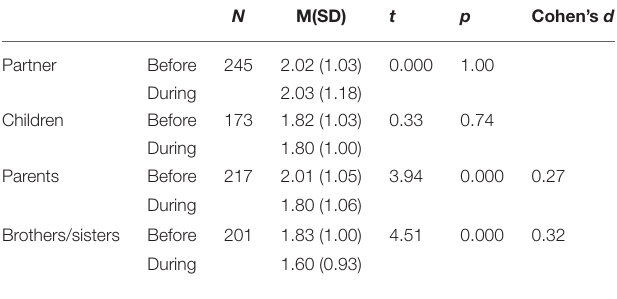
TABLE 2 | Perception of conflict before and during the lock-down with the people women live with. N M(SD) t p Cohen’s